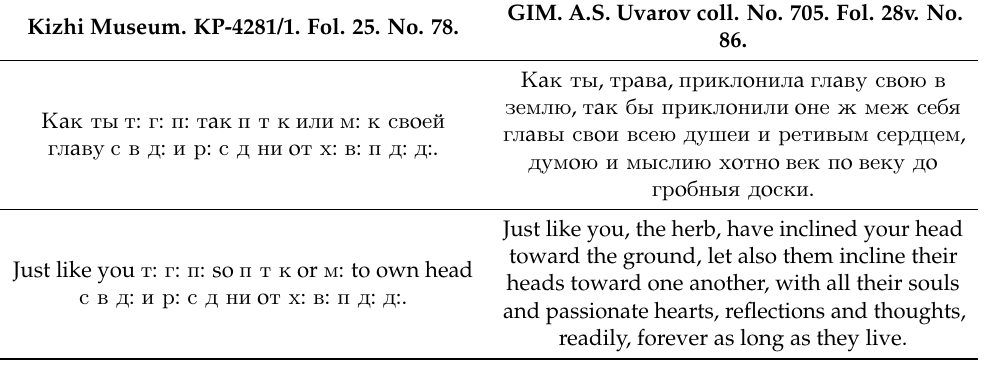
Table 5. Texts about the Ulik